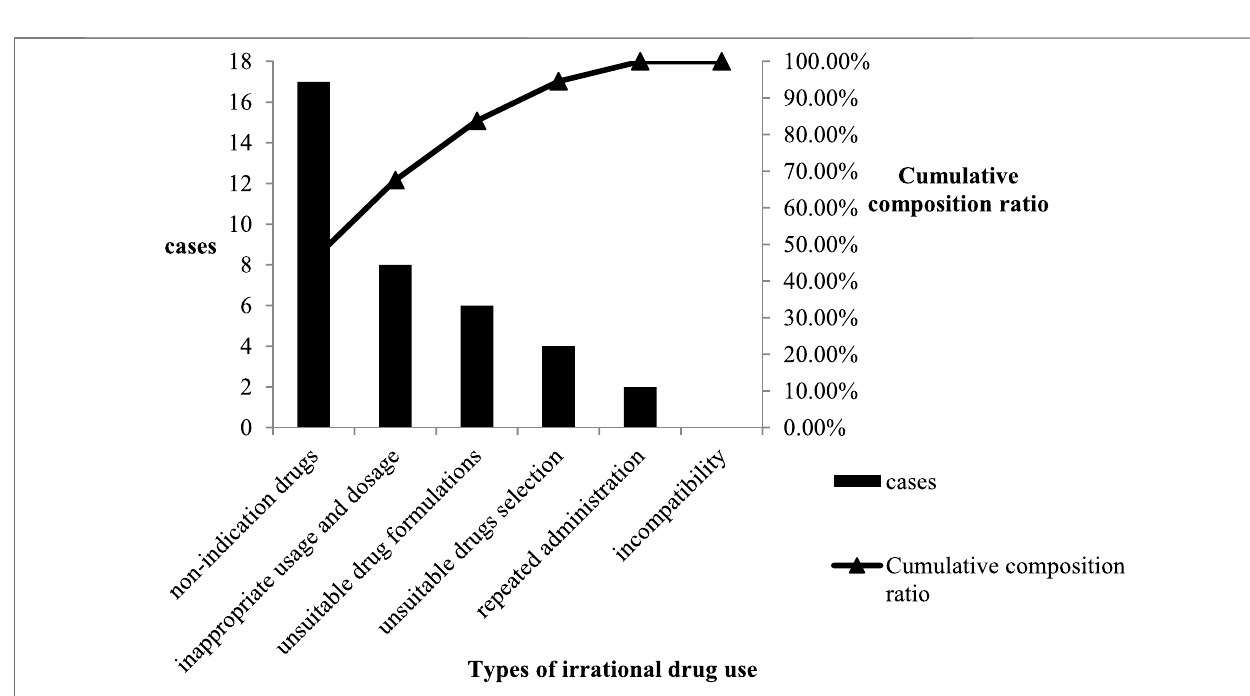
FIGURE 3 | Pareto chart of types of irrational drug use in